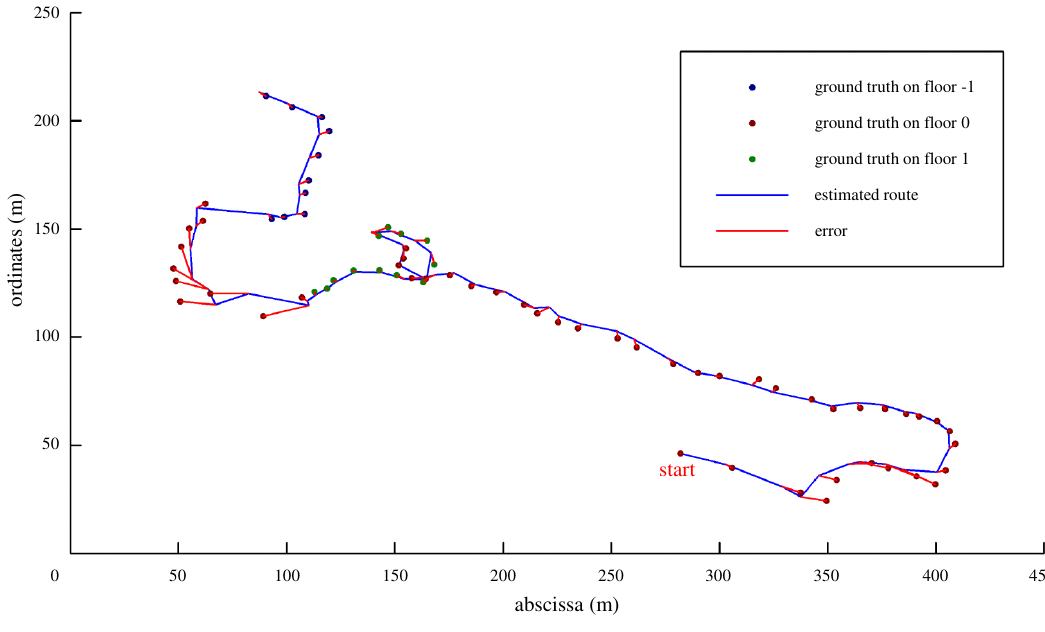
Figure 15. Experiment 2: evaluation in IPIN 2018 Competition Track